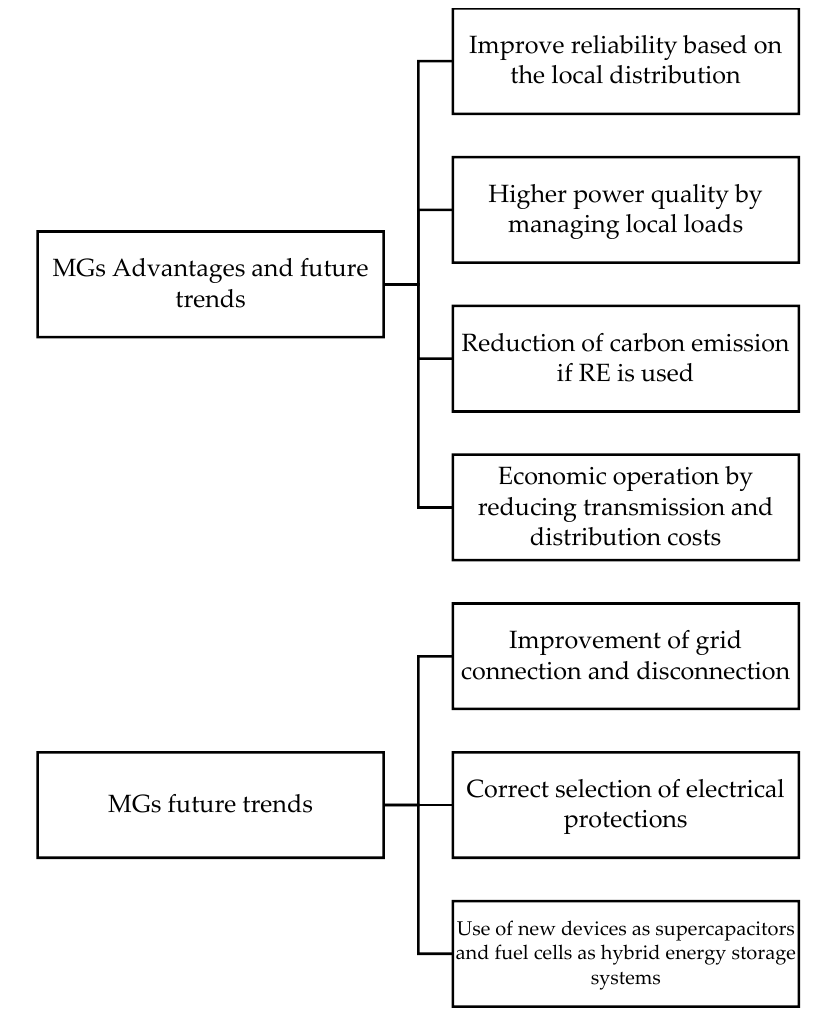
Figure 1. Main advantages of the use of MGs and future trends (source: own elaboration).